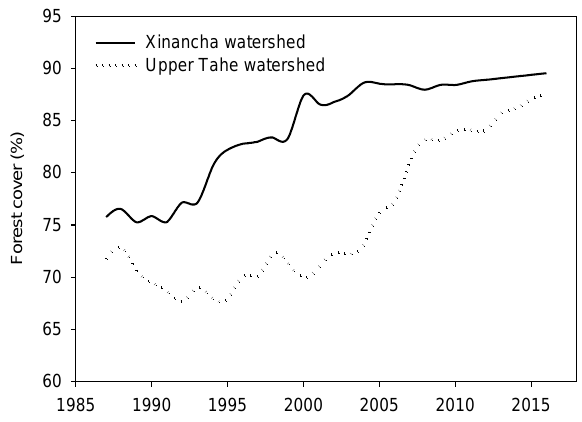
Figure 3. Forest cover (%) from 1987 to 2016 in UTH watershed and XNC watershed.